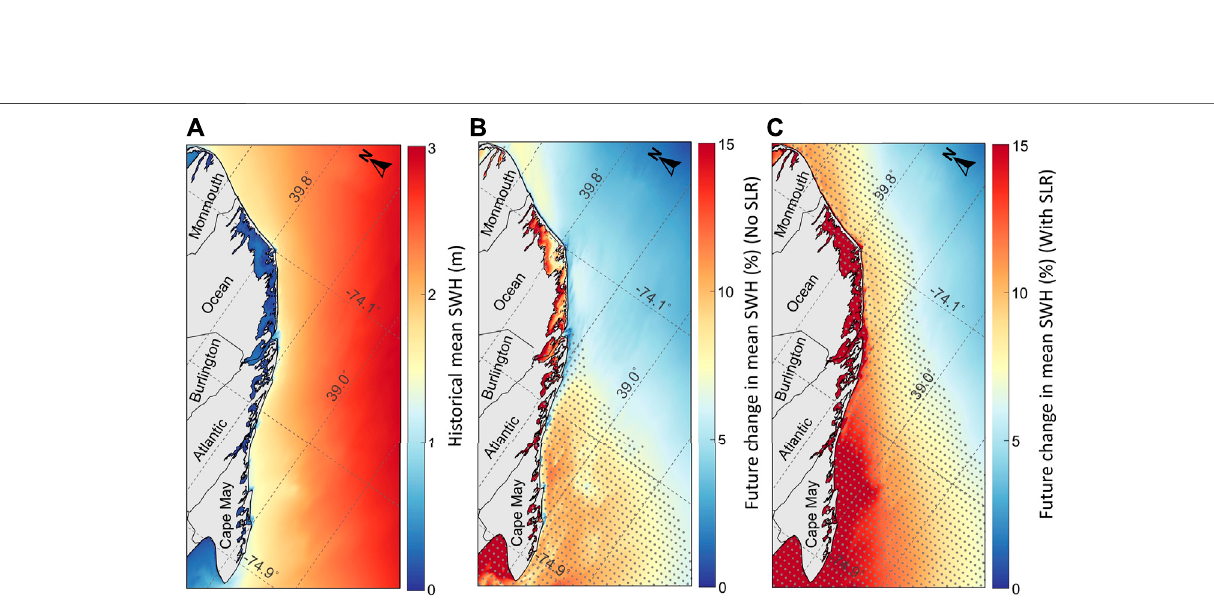
FIGURE 6 | (A) Model-based historical mean SWH metric. (B) Projected changes by the end of 21st century under RCP8.5 scenario for the No-SLR scenario. (C) Same as (B) but for the With-SLR scenario. Stippling denotes areas where projected changes are statistically signi fi cant (with a con fi dence level of at least 95%). The scale bars in (B,C) are different from that in (A)